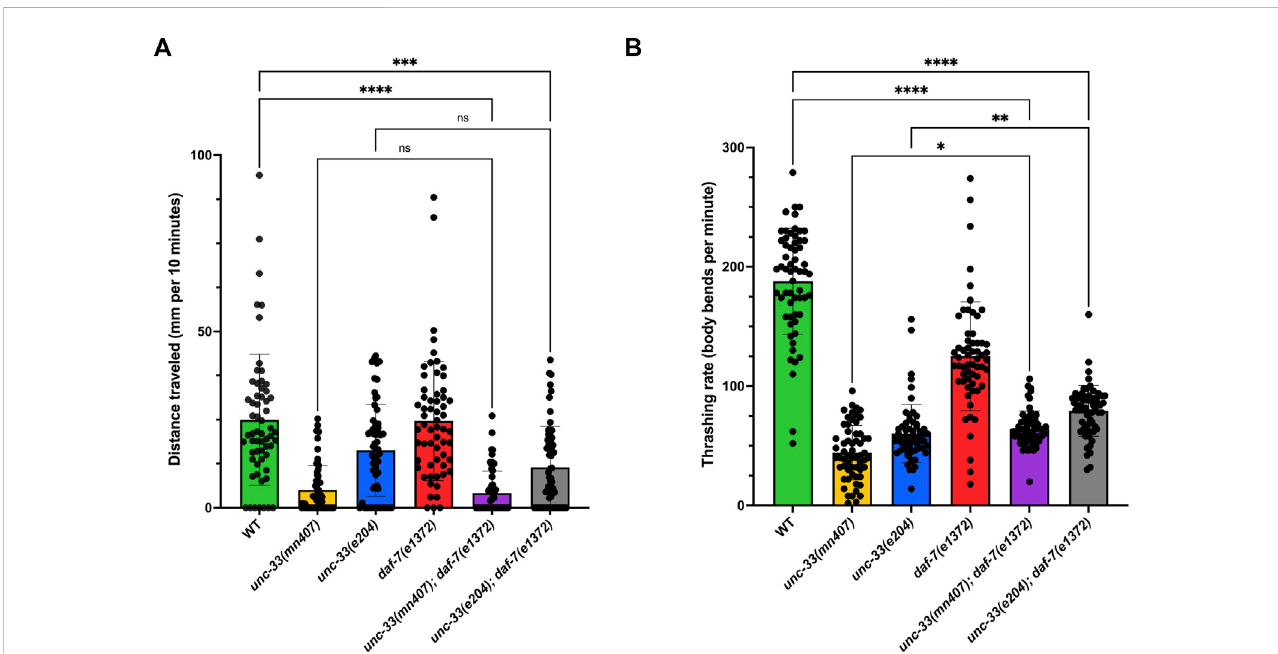
FIGURE 4 unc-33; daf-7 mutant adults that were previously dauers show that locomotion defect persists (A) Average distance traveled in millimeters per 10 minutes for each strain on a plate seeded with OP50 E. coli . (B) Average thrashing rate (body bends per minute) for each strain in liquid media. Statistical analyses using Kruskal – Wallis ’ s tests followed by Dunn ’ s multiple comparisons show no signi fi cant differences (ns) between double mutants unc-33; daf-7 and their unc-33 single mutant counterpart. However, unc-33(mn407) and unc-33(e204) were statistically different from wildtype ( p < 0.001). n = 60 animals per